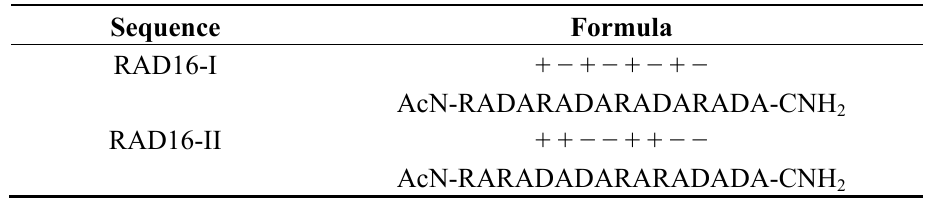
Table 4. Two different RAD16